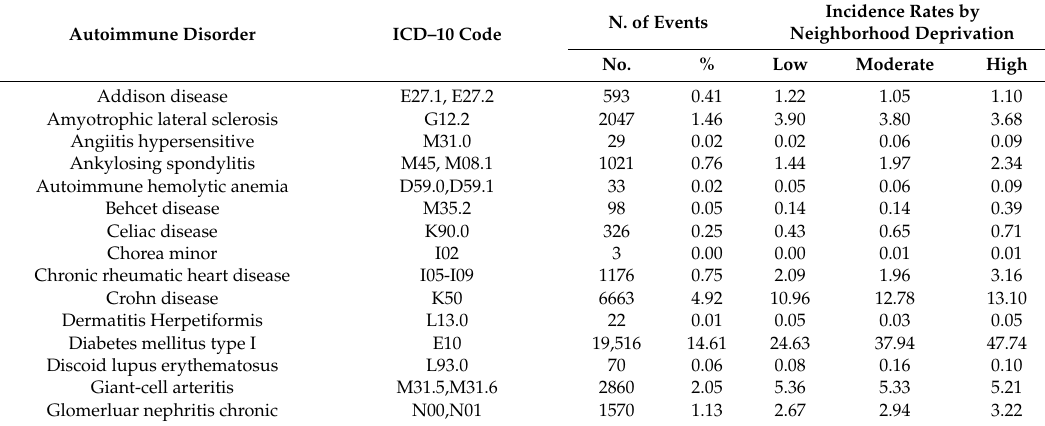
Table 3. Number of autoimmune disorder events, and age-standardized incidence (per 10,000 individuals) by neighborhood-level